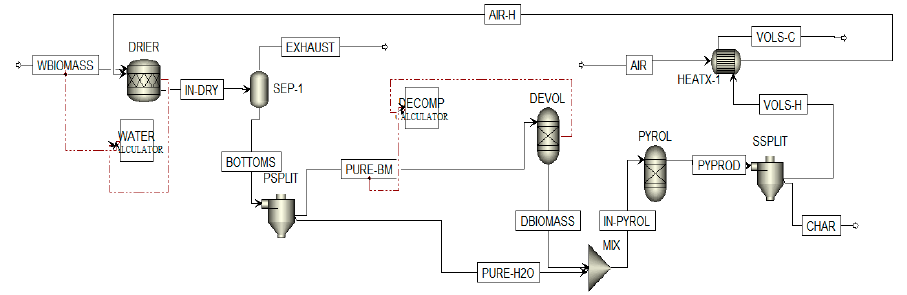
Figure 1. Aspen Plus simulation for pyrolysis.